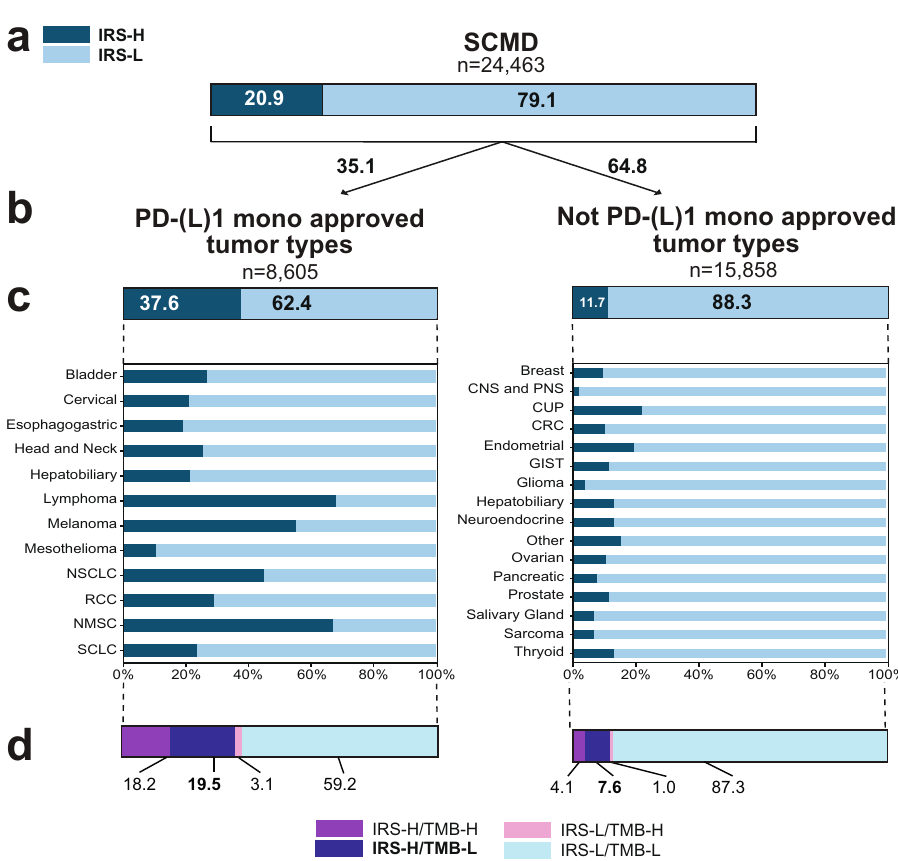
Fig. 5 Pan-solid tumor distribution of immunotherapy response score (IRS) groups. a IRS groups were determined for all 24,463 patients in the Strata Clinical Molecular Database (SCMD) with informative tumor mutation burden (TMB) and gene expression data needed to generate IRS. IRS group (Low [L; light blue] vs. High [H; dark blue]) distribution is shown by box plot (numbers indicated percentages). b Strati fi cation of the 24,463 patients by approved and non-approved PD-(L)1 monotherapy tumor types. c Breakdown of b by individual tumor types. d Breakdown of b by IRS and TMB (High [H] vs. Low [L]; TMB-H as ≥ 10 mutations/megabase). Results may not add up to 100% or be equivalent in sub-analyses due to rounding. Tumor type abbreviations: NSCLC (non-small cell lung cancer), RCC (renal cell carcinoma), NMSC (non-melanoma skin cancer), SCLC (small cell lung cancer), CNS and PNS (central nervous system and peripheral nervous system), CUP (cancer of unknown primary), CRC (colorectal cancer), GIST (gastrointestinal stromal